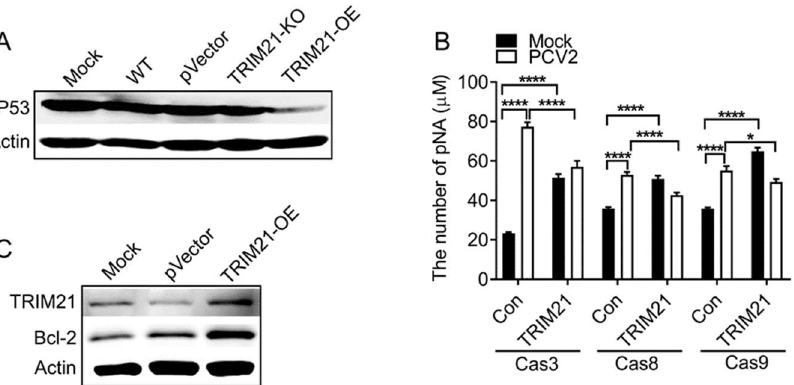
Figure 4. Porcine TRIM21 decreases cellular apoptosis in PCV2-infected cells. ( A ) p53. PK-15 cells were infected with PCV2 for 72 h, followed by Western blot. ( B ) Caspase 3, 8, and 9 activities. PK-15 cells (control cells, Con) and TRIM21-OE cells were infected with PCV2 for 72 h, followed by caspases activities analysis using the Caspase (3, 8, and 9) Activity Assay Kit. * p < 0.05; **** p < 0.0001. ( C ) Bcl-2. PK-15 cells were infected with PCV2 for 72 h, followed by Western blot. Mouse anti-P53 monoclonal antibody (1:1000), mouse anti-Bcl-2 polyclonal antibody (1:1000), and mouse anti-β-actin antibody (1:2000) were used as primary antibody, and HRP-labeled goat anti-mouse IgG (H + L, 1:2000) was used as the secondary antibody. Unprocessed original images can be found in Supplementary Figure S4.